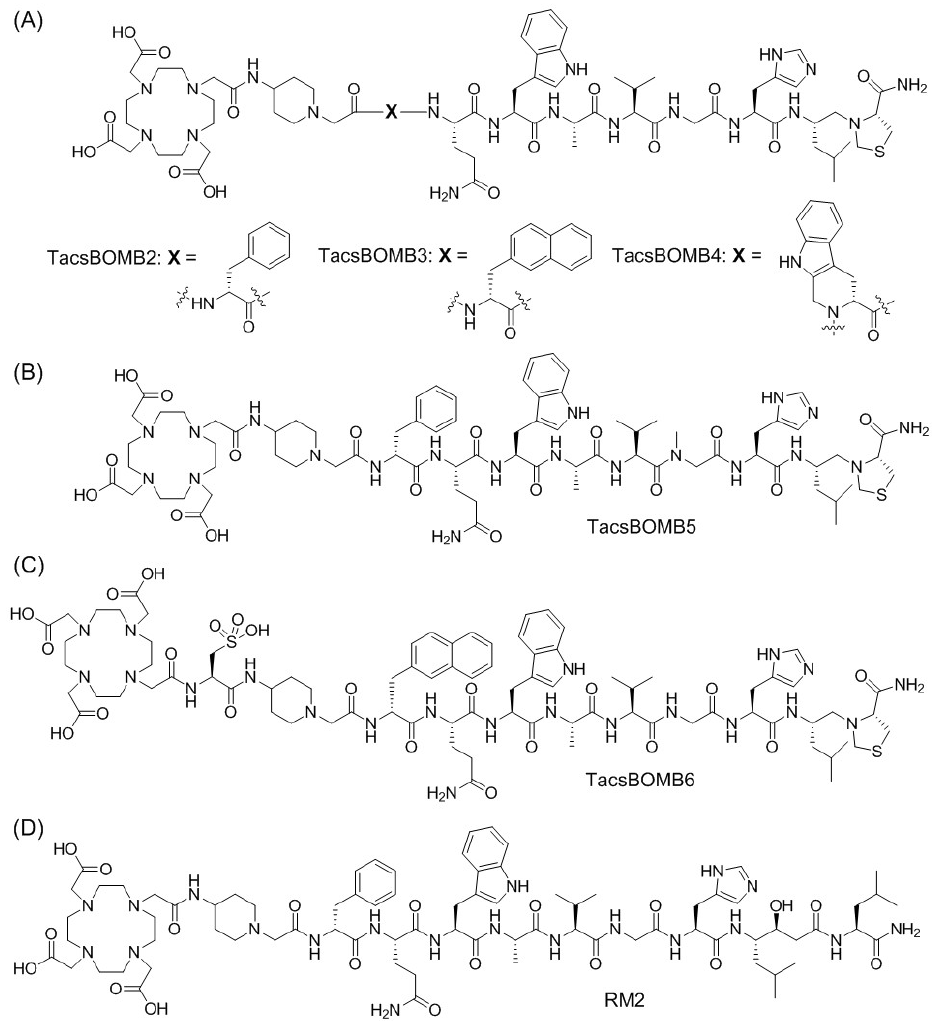
Figure 1. Chemical structures of ( A ) TacsBOMB2, TacsBOMB3, and TacsBOMB4, ( B ) TacsBOMB5, ( C ) TacsBOMB6, and ( D ) RM2.